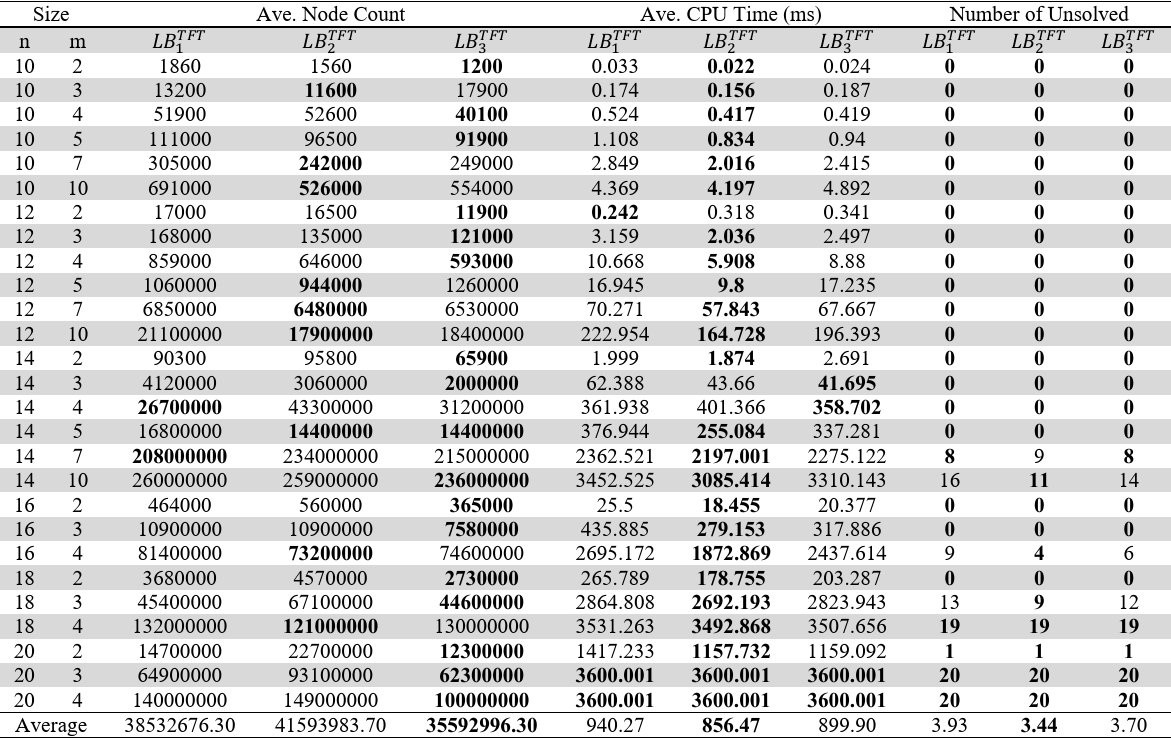
Comparison of the variations of 𝐿𝐵 (cid:3021)(cid:3007)(cid:3021) – Database